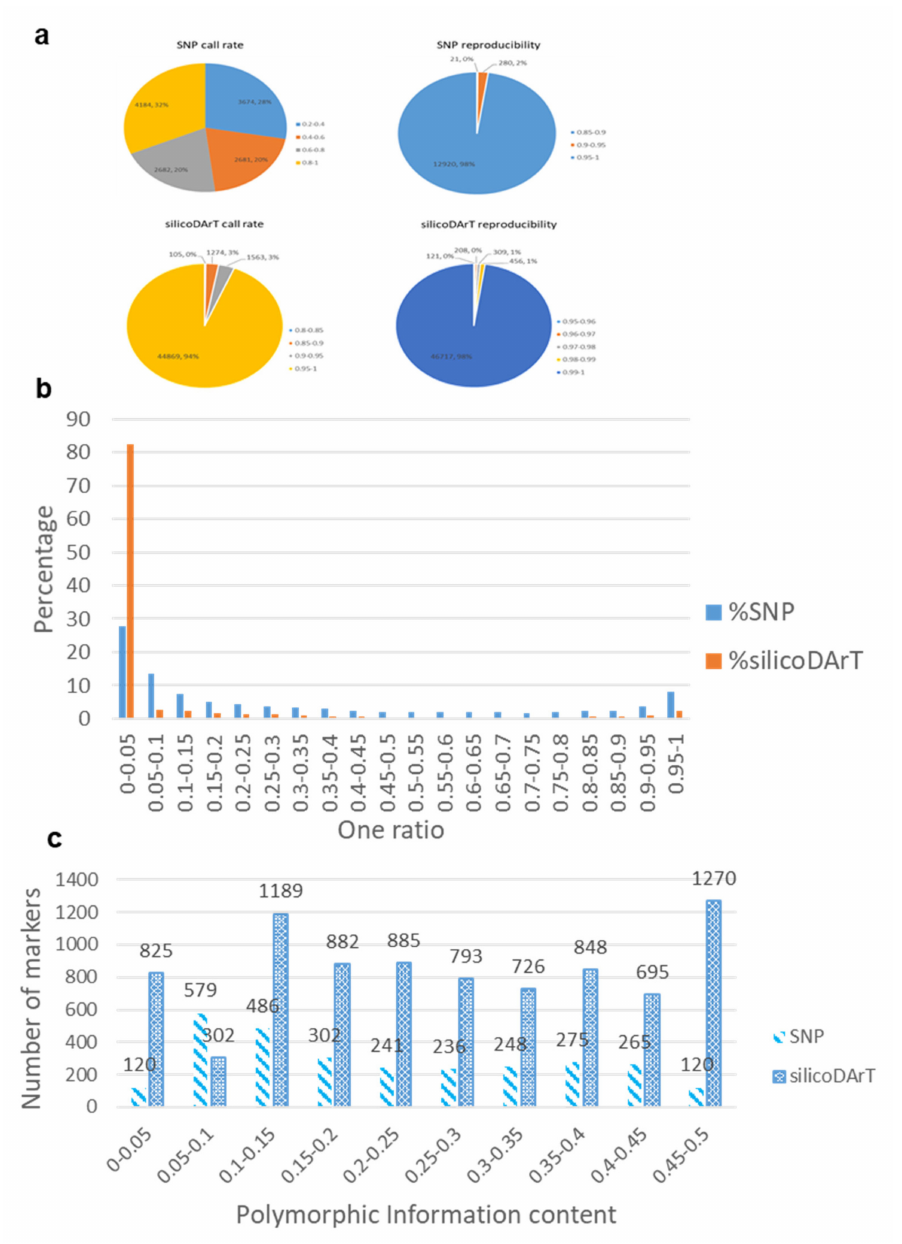
Figure 1. Distribution of SNP and silicoDArT marker data for several quality parameters. ( a ) call rate and reproducibility; ( b ) one ratio and ( c ) polymorphic information content (PIC)